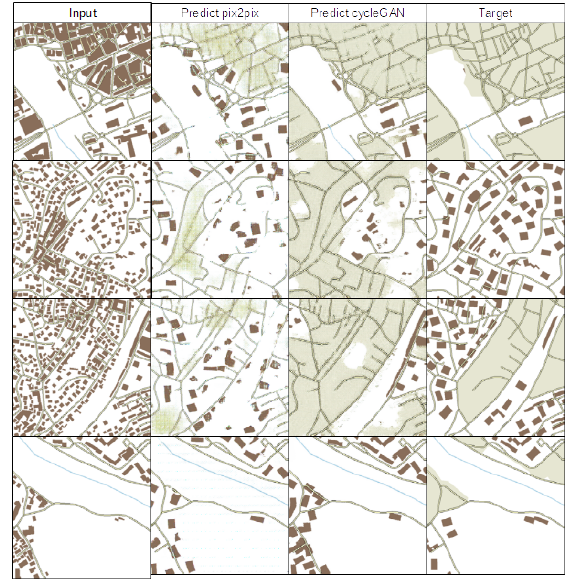
Figure 4. Examples of results from pix2pix and CycleGAN